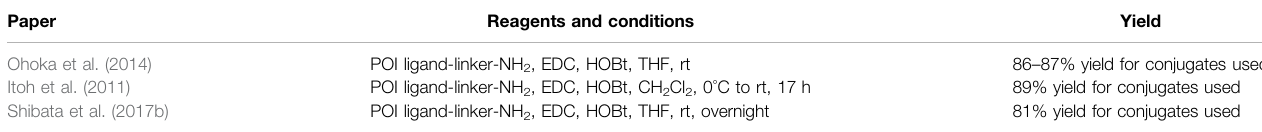
TABLE 6 | Reagents, conditions, and yields for the conversion of 199 to 200 ( Scheme 34 , step b).